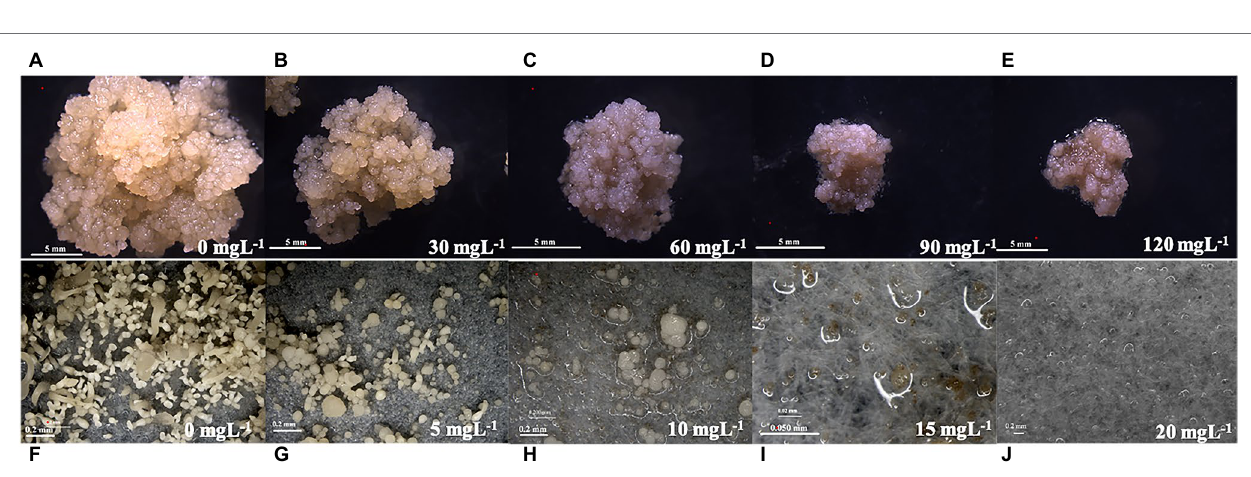
FIGURE 3 | Effect of different mass concentrations of Geneticin (G418) on the growth of embryogenic calli and somatic embryo regeneration of the Liriodendron hybrid. Plate images showing the proliferation and tolerance level of the callus ( A–E : 0, 30, 60, 90, and 120 mg L − 1 ; bar: 5 mm), and somatic embryos [ F–J : 0, 5, 10, 15, and 20 mgl − 1 ; (F–H,J) : bar: 0.2 mm; I: bar: 0.05 mm] under selective